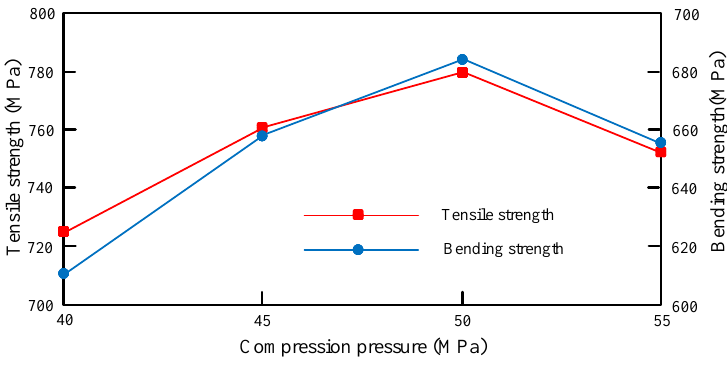
Figure 10. Mapping relationship between compression pressure and mechanical properties.